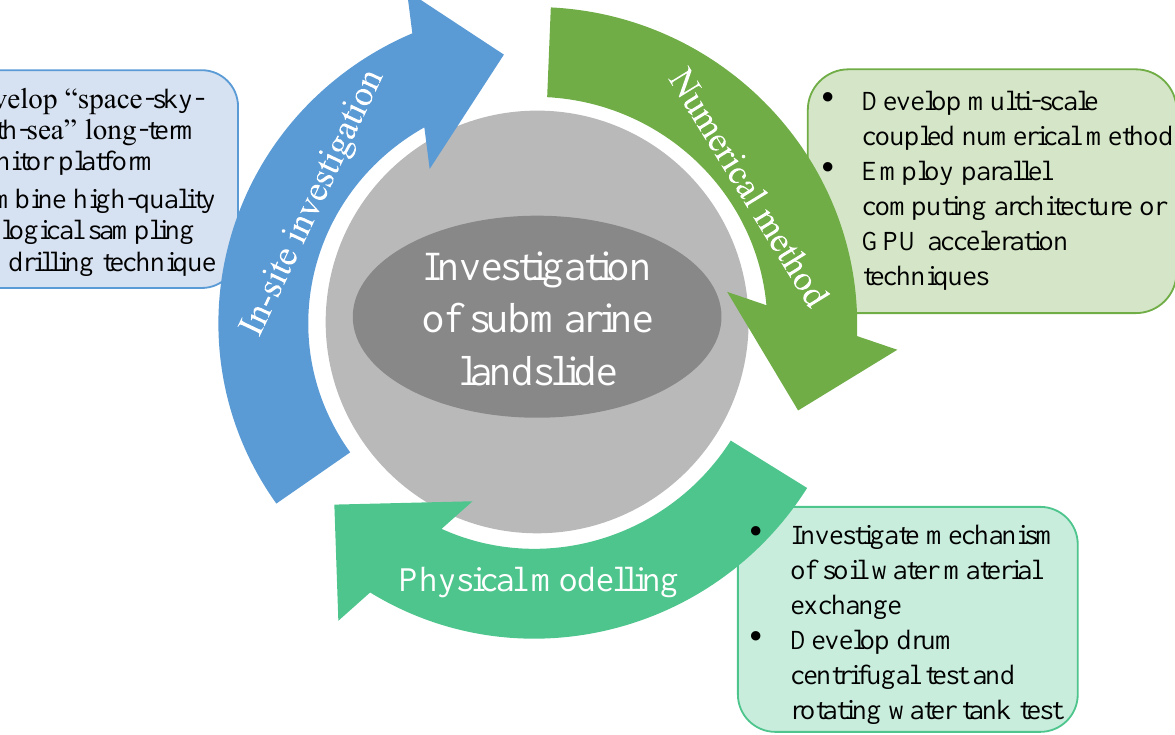
Figure 7. Future research directions of submarine landslides.